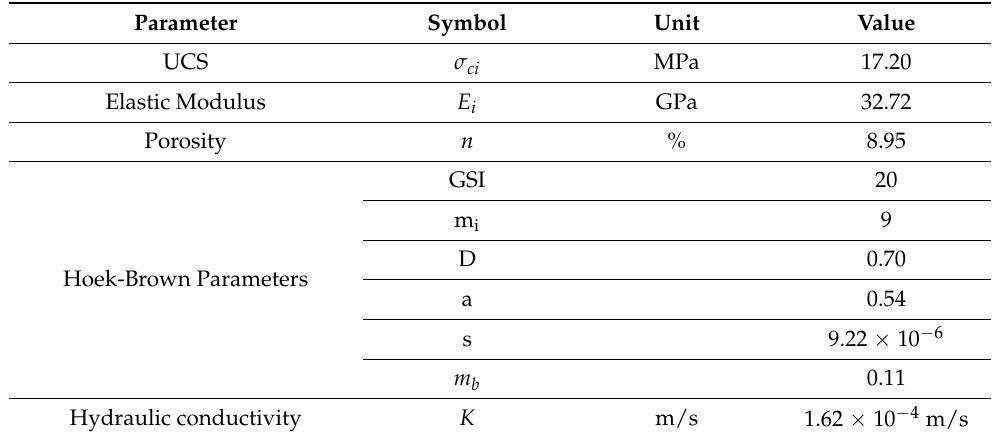
Table 1. Input parameters.